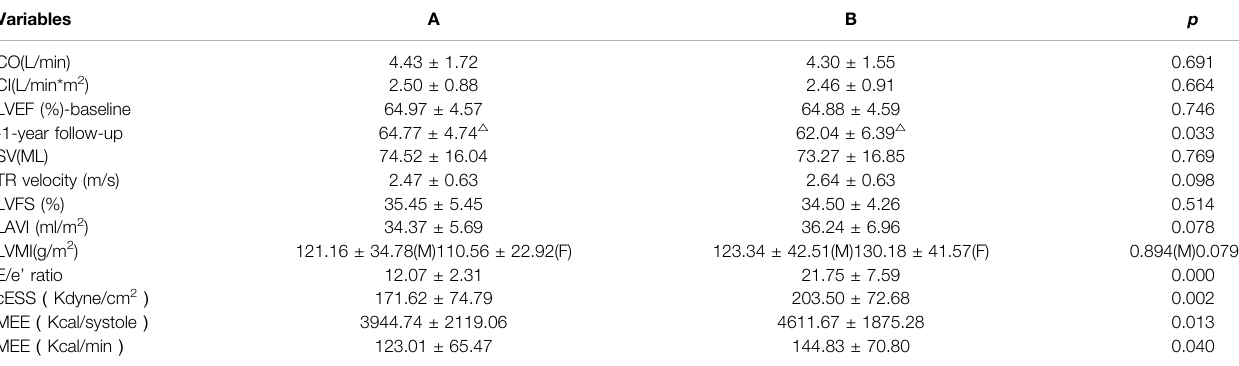
TABLE 2 | The baseline Echocardiogram measurements of study population.